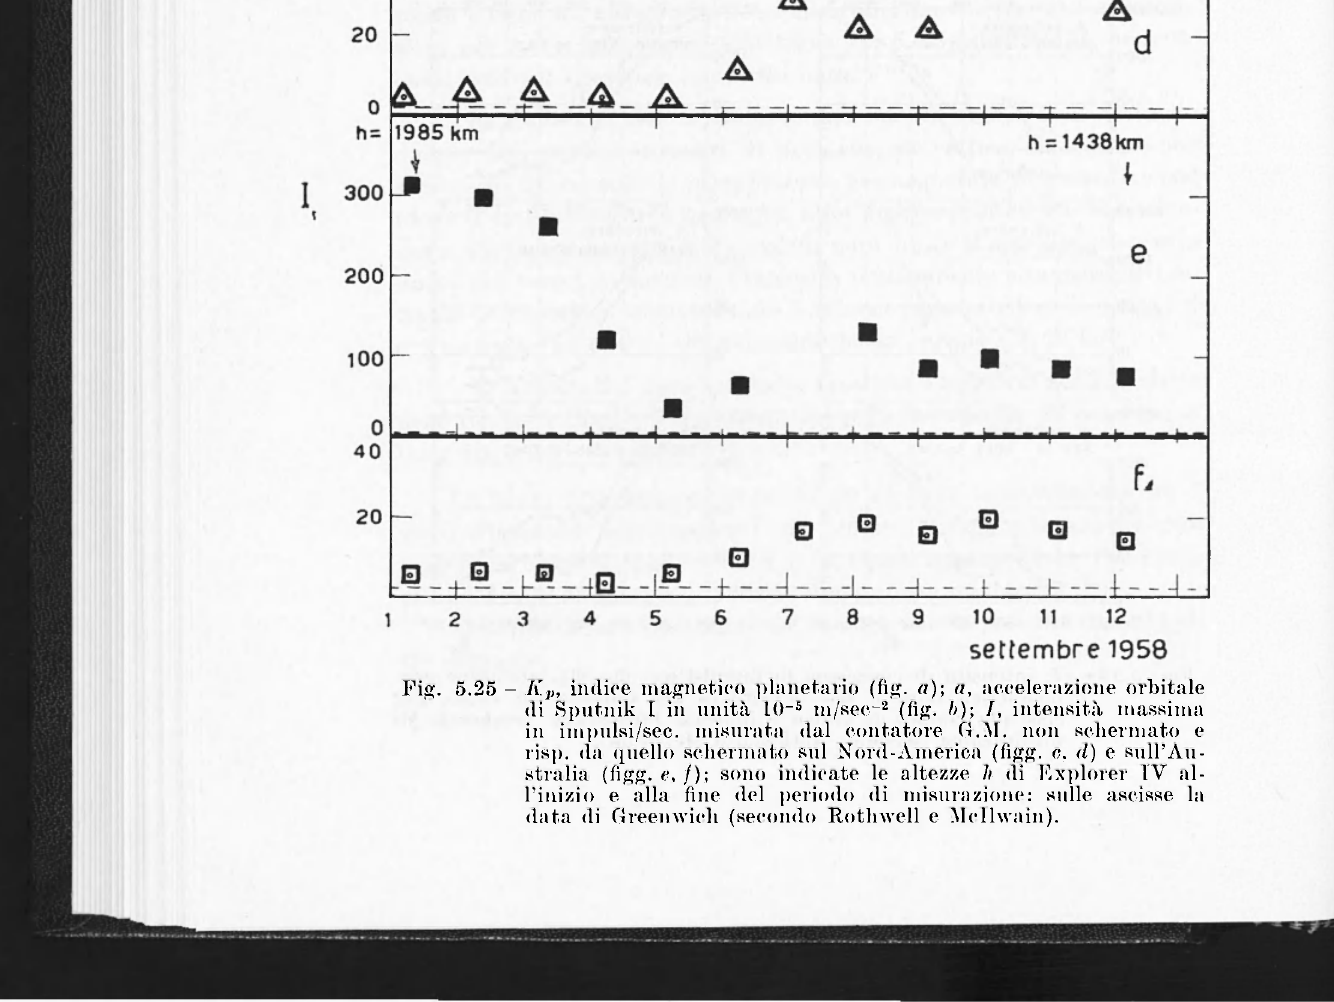
Fig. 5.25 - K p , indice magnetico planetario (fig. a); a, accelerazione orbitale di Sputnik I in unità IO -5 m/sec~ 2 (fig. b); I, intensità massima in impulsi/sec. misurata dal contatore G.M. non schermato e risp. da quello schermato sul Nord-America (figg. c, d) e sull'Au- stralia (figg. e, / ); sono indicate le altezze li di Explorer IV al- l'inizio e alla fine del periodo di misurazione: sulle ascisse la data di Greenwich (secondo Rothwell e